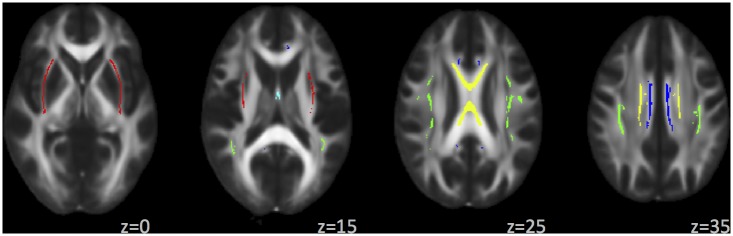
Tracts included in the White Matter Factor (WMF), shown on FSL’s FMRIB58 FA image.Color legend: external capsule, red; fornix, light blue; body of corpus callosum, yellow; cingulate gyrus, dark blue; superior longitudinal fasciculus, green.